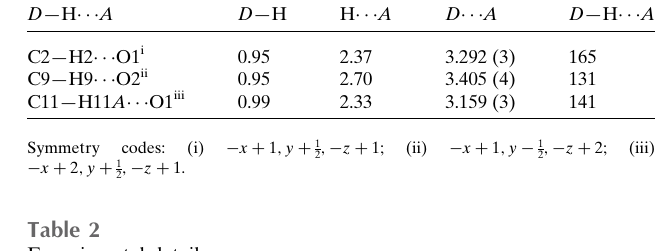
Table 2 Experimental